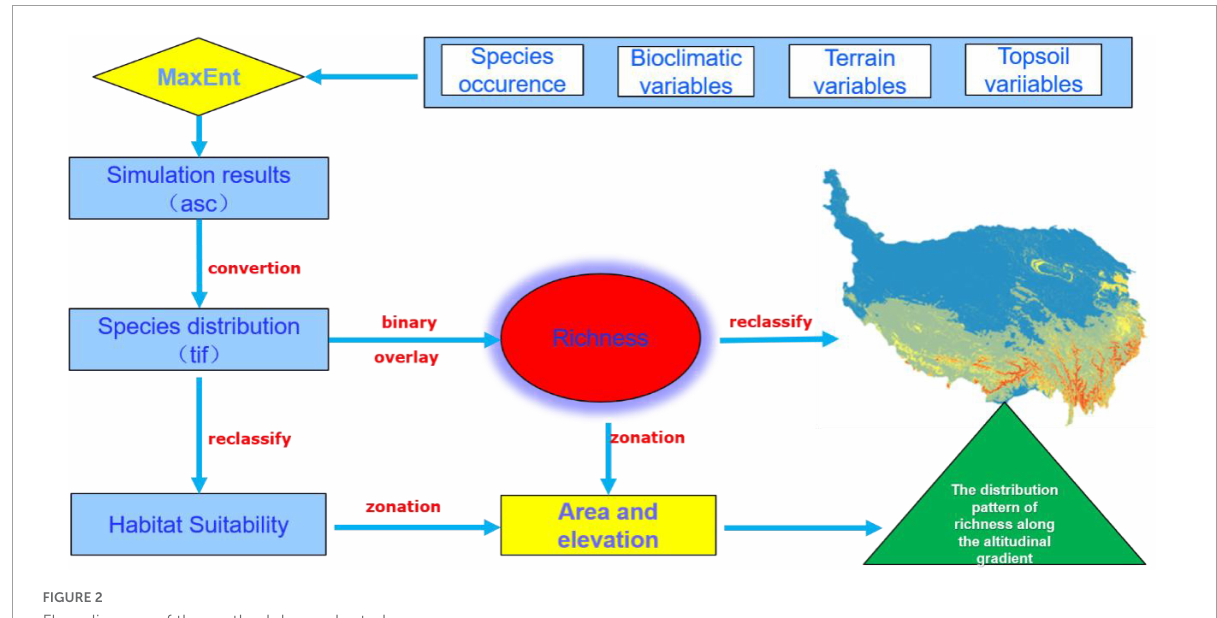
FIGURE2 Flow diagram of the methodology